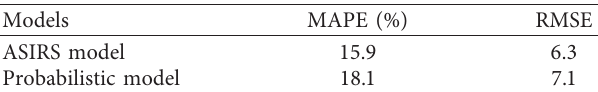
Table 8: MAPE and RMSE of the two models compared with historical data.